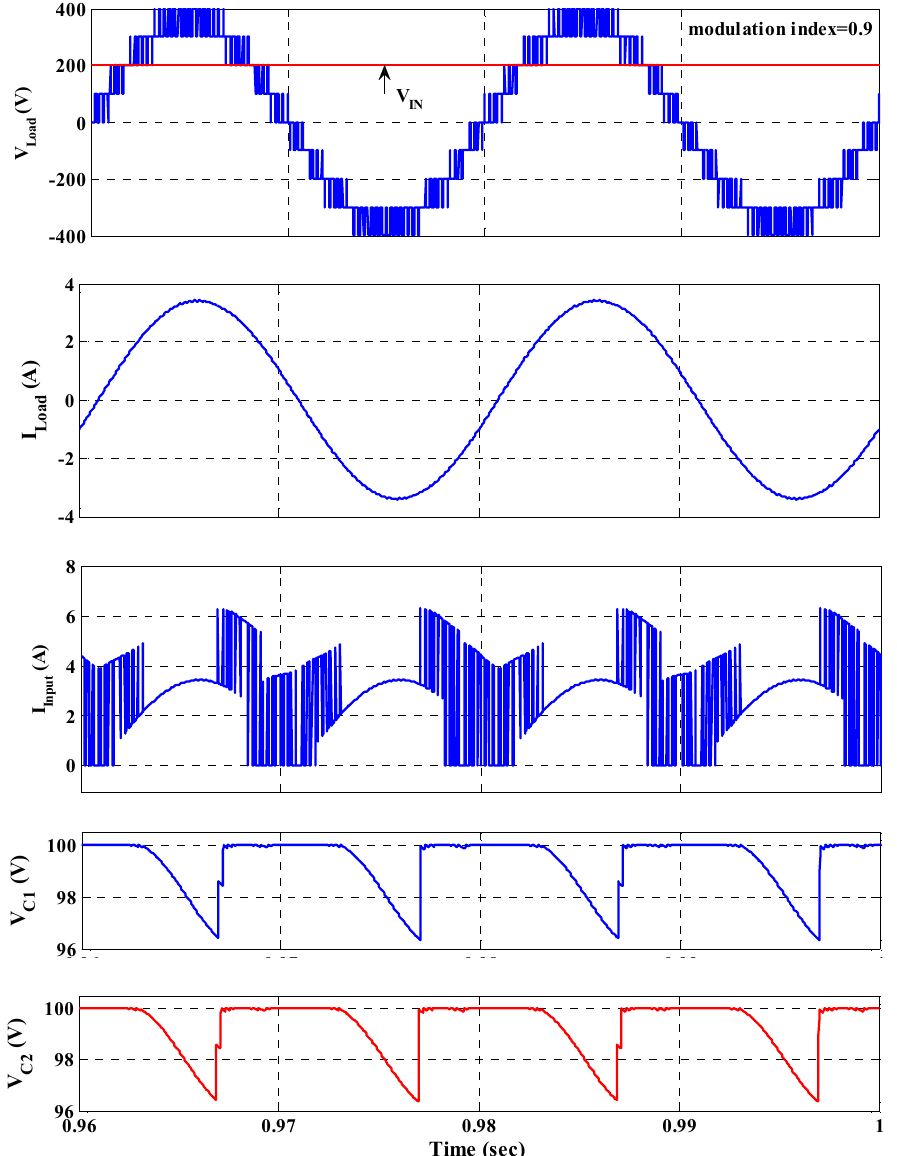
Figure 7. Operation of the presented model under constant load.